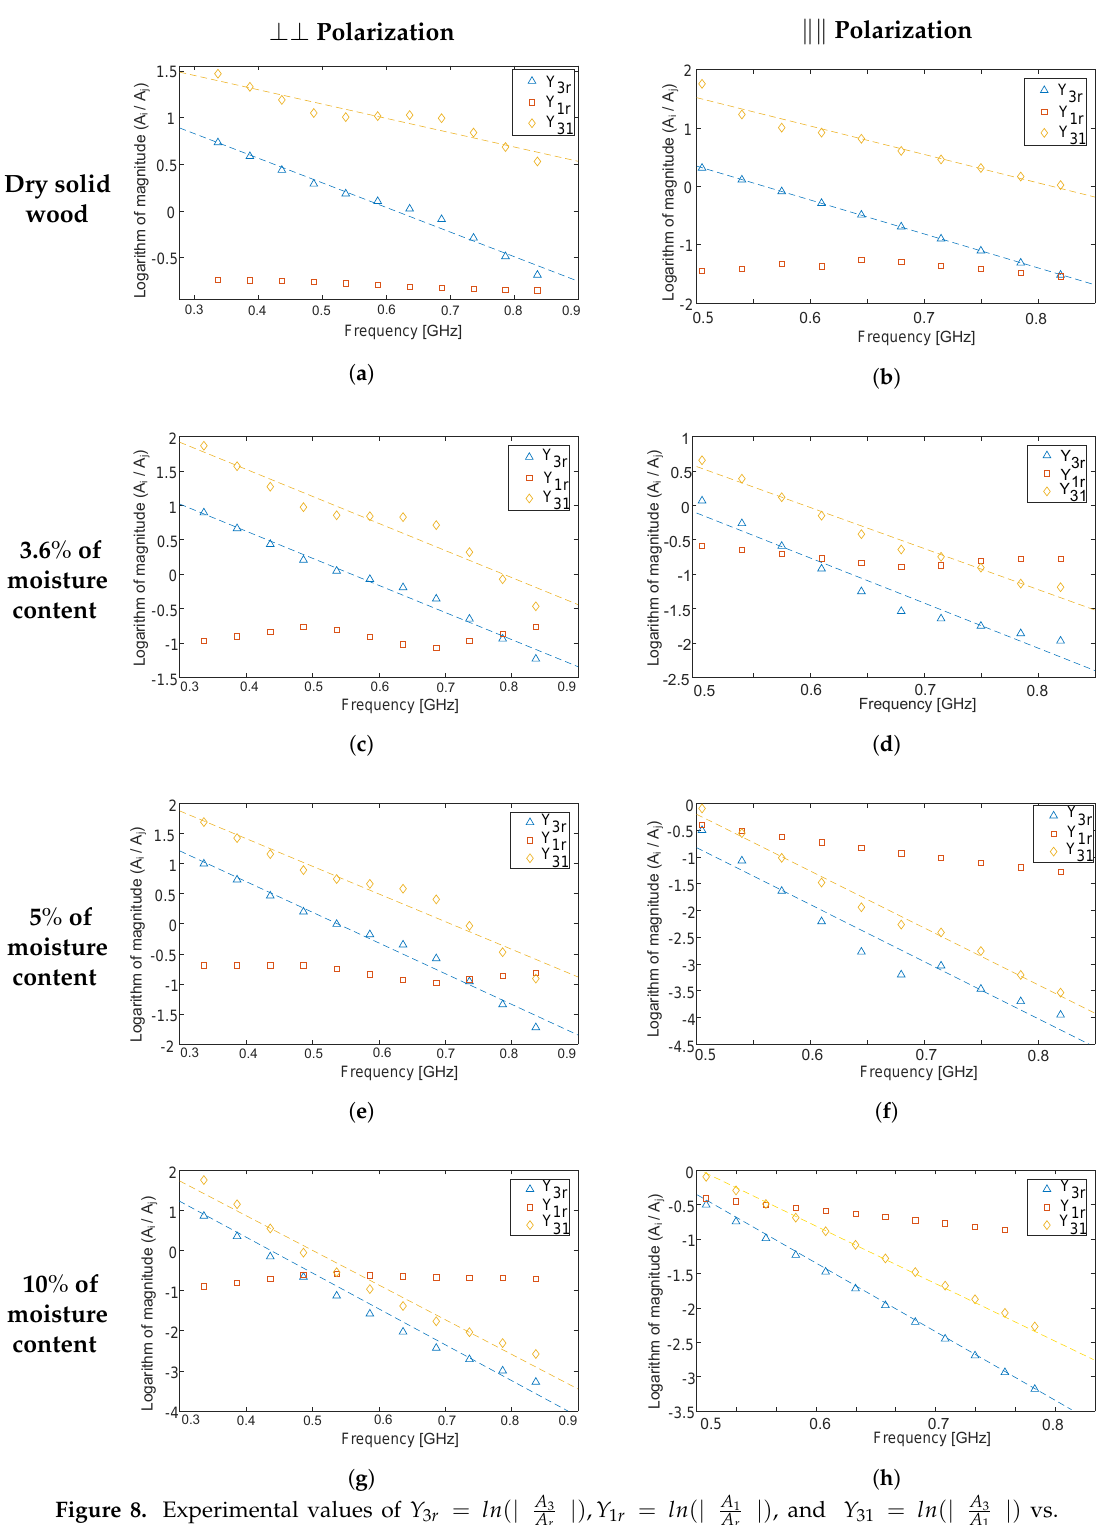
Figure 8. Experimental values of Y 3 r = ln ( | A 3 the frequency for different moisture content values (for Object A) and for polarization states ⊥⊥ and (cid:107)(cid:107) as shown in the